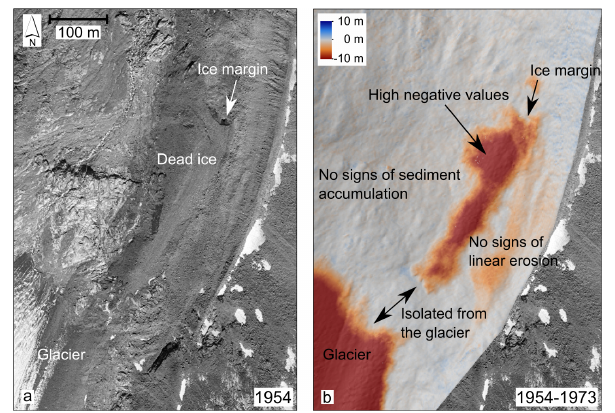
Figure 2. Detection of debris-covered dead ice for the example of the Alpeiner Ferner: (a) orthophoto of 1954 and (b) 1954–1973 DoD (the aerial images of 1954 are from BEV, while those of 1973 are from the State of Tyrol, Austria).